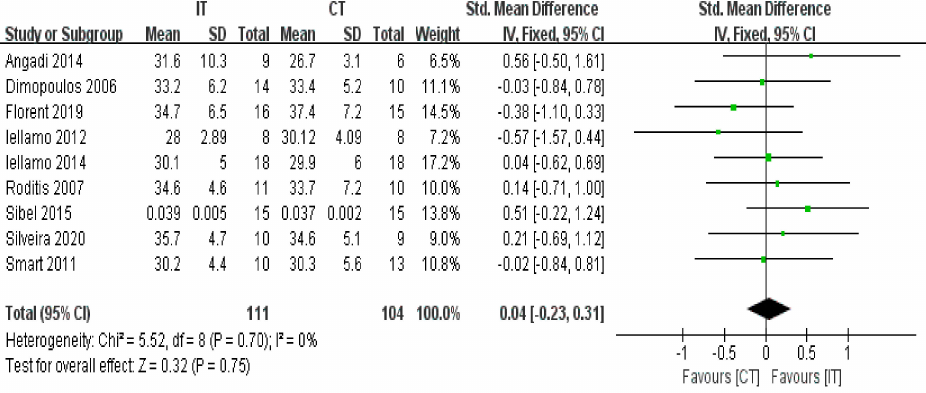
Figure 5. Forest plot: Effects of VE/VCO2 slope.